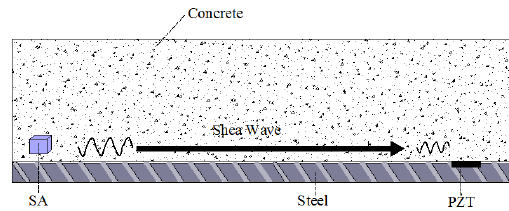
Figure 5. Demonstration of the shear wave-based active sensing approach used in a concrete-encased composite structure [82].